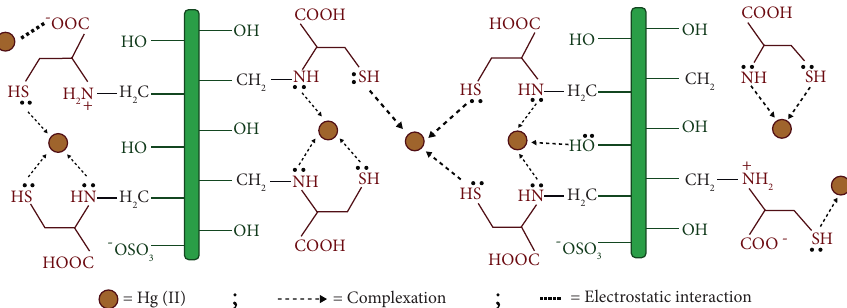
Figure 13: Interaction between CNC-Lcys and Hg(II) ions makes higher specifc surface area of the nanoadsorbent. Hg(II) ions will be bonded with the CNC-Lcys surface with the lone pair of S and N atoms through the complexation and with the lone pair of O atoms through the electrostatic interaction. Tis results in a more bonding contact between the CNC-Lcys and Hg(II) ions and forming a stable binding [36]. Copyright and permission from Royal Society of Chemistry-2019. Table 6: Te adsorption isotherm models of various modifed CNCs and